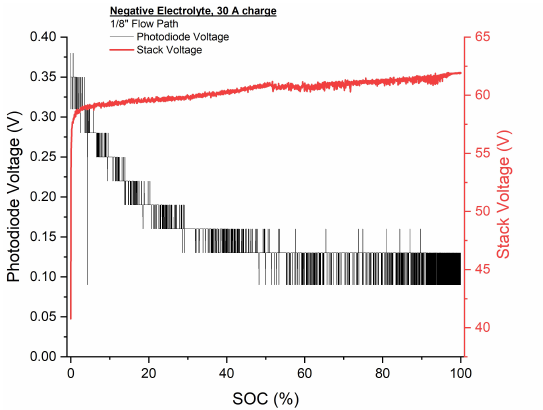
Figure 9. Negative electrolyte absorbance test utilizing a 1/8 (cid:48)(cid:48) flow cell (30 A charge)